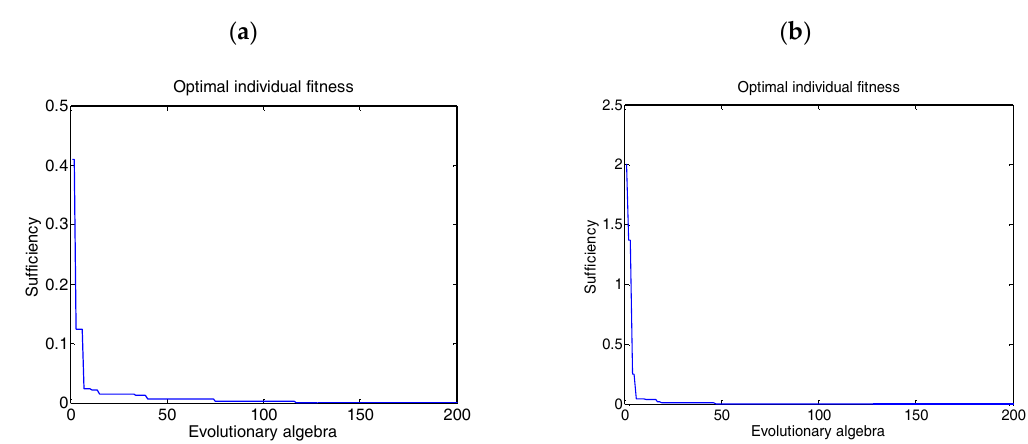
Figure 4. Optimal individual fitness ( a ) PSO algorithm; ( b ) Adaptive mutation PSO algorithm.